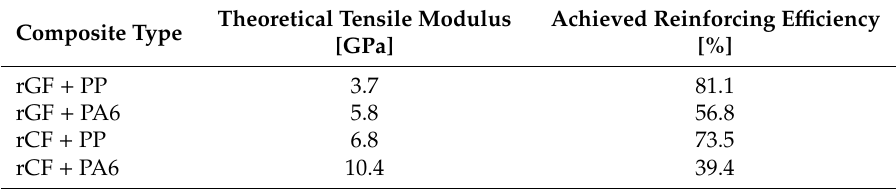
Table 5. Tensile moduli of the composite materials predicted by the Halpin-Tsai equation. The reinforcing e ffi ciency is calculated by comparing the theoretical and best experimental